Question: What type of chart is this?
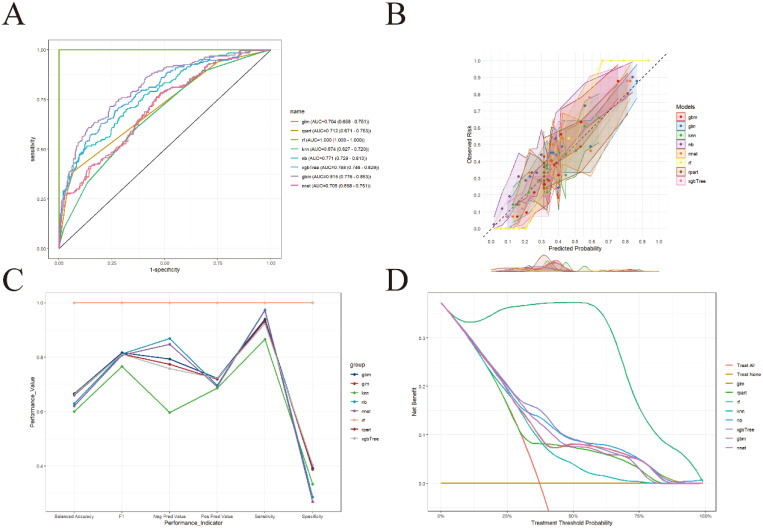
Answer: line